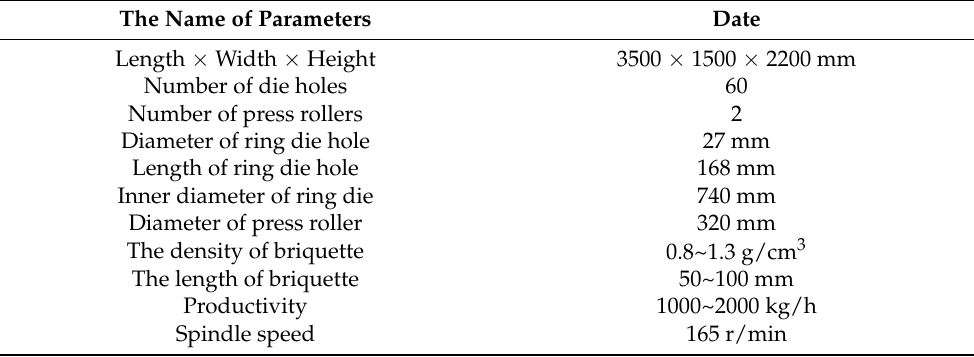
Table 1. Property parameter of 9JYK-2000A-type straw briquetting machine with vertical ring